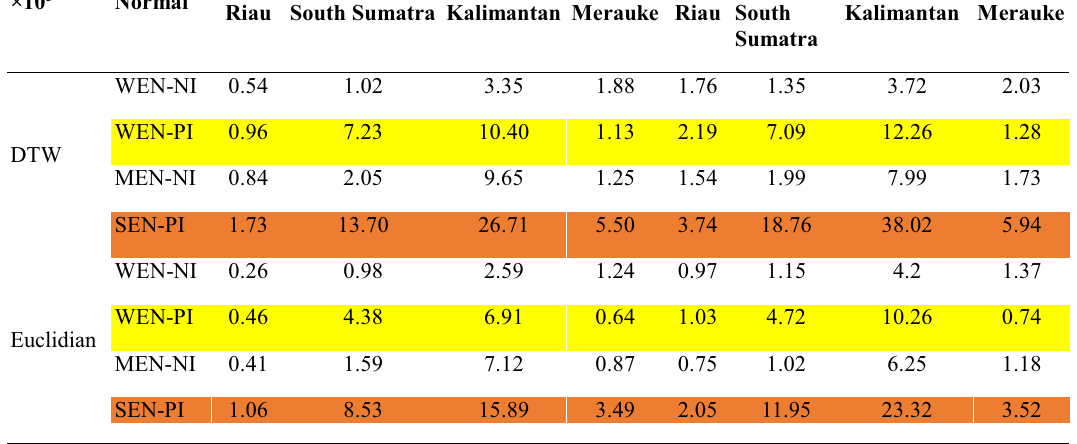
Table 2 DTW and Euclidian distance results for each category Mean signal (average condition) Max signal (worst condition) ×10 5 Normal